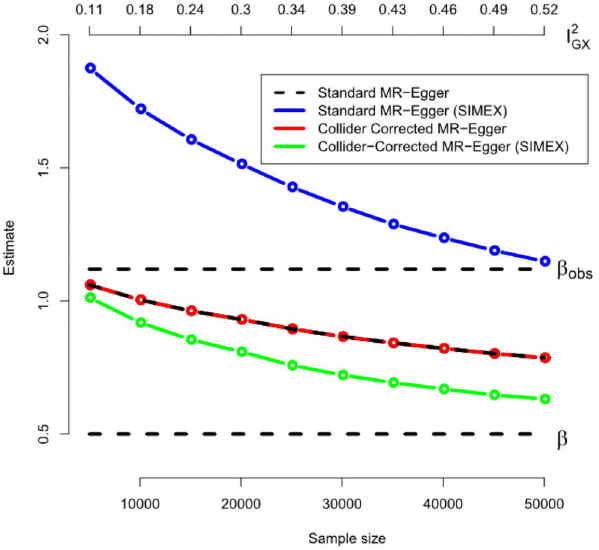
Figs 8B and 9B show the corresponding standard deviation and mean squared error for all MR-Egger-based methods across the same set of simulations. Standard and Collider-Corrected MR-Egger are seen to have the joint smallest variance, but Collider-Corrected MR-Egger with SIMEX adjustment has the smallest mean-squared error because it is far less biased. LAD-regression simulation results. Fig 12 shows for a range of sample sizes the average value across 1000 independent data sets of: (a) The standard (one-sample) LAD-regression